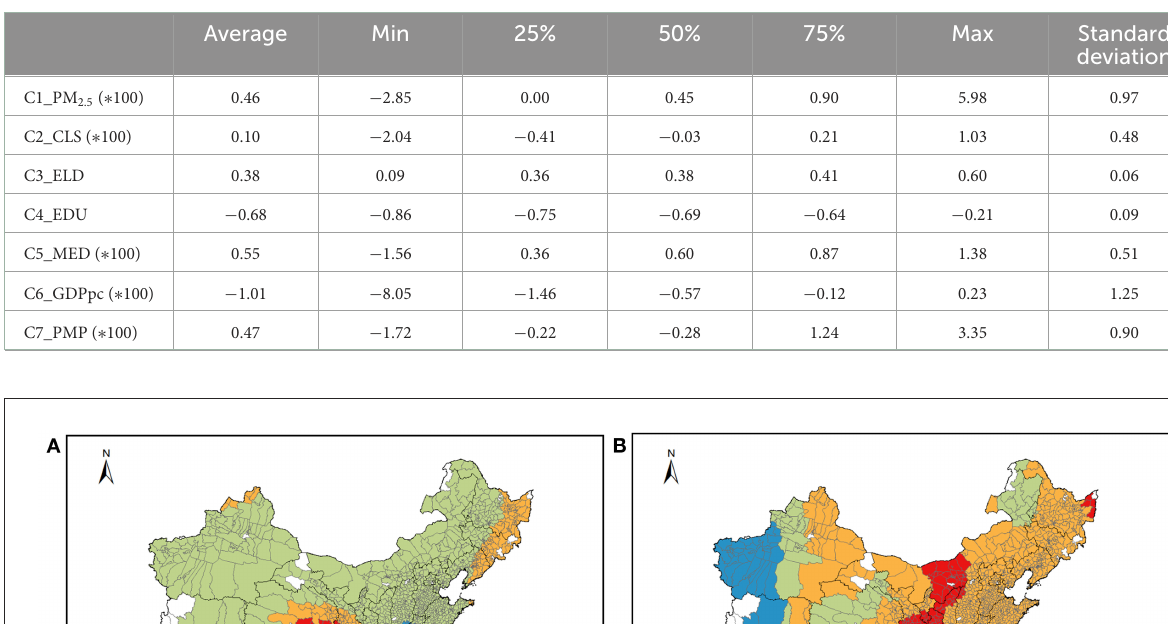
TABLE 4 GTWR model test results.